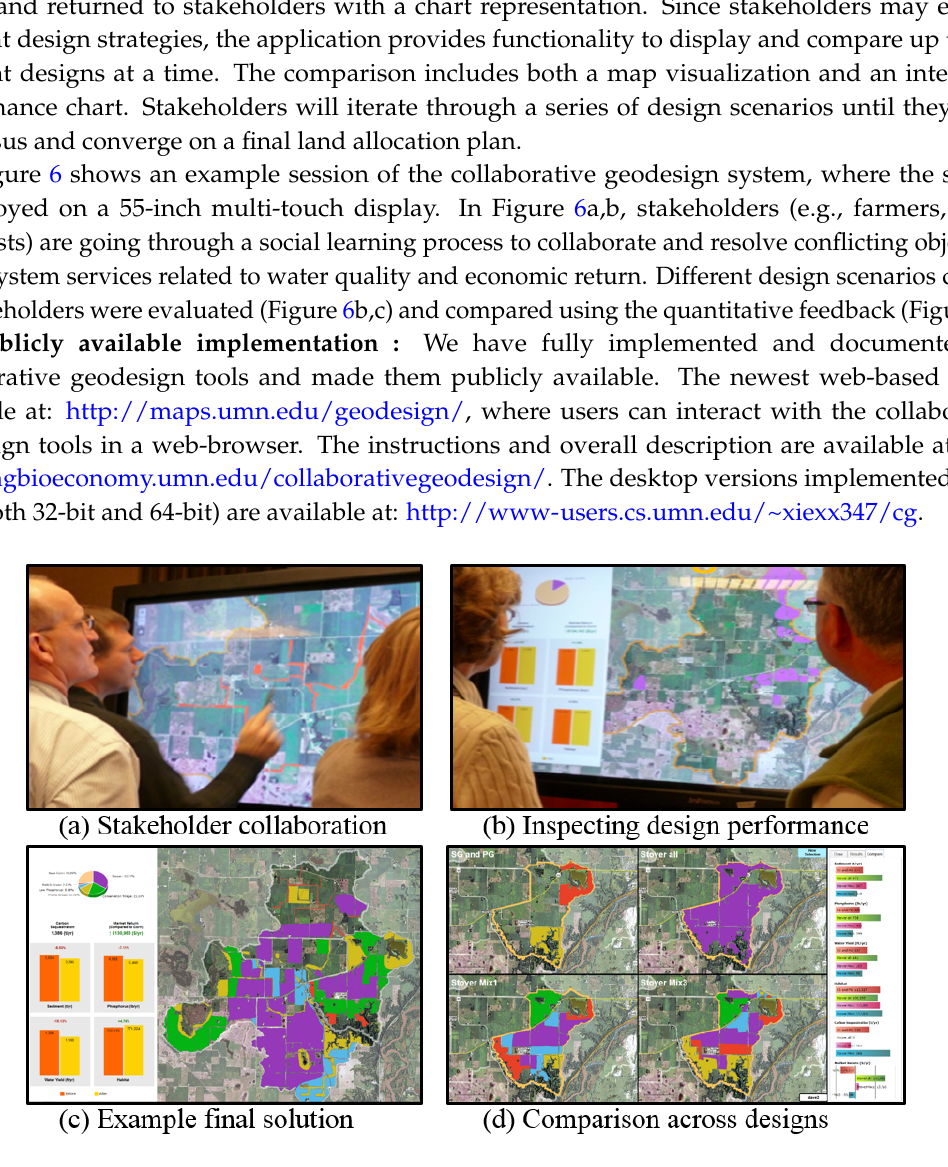
Figure 6. Software developed to engage stakeholders in creating and evaluating land allocations. ( a ) Stakeholders work together to hand-craft designs using the interactive interface. ( b ) Design performance is evaluated and returned to stakeholders for discussion. ( c ) An example design with charts showing performances. ( d ) Stakeholders can compare multiple designs and evaluate